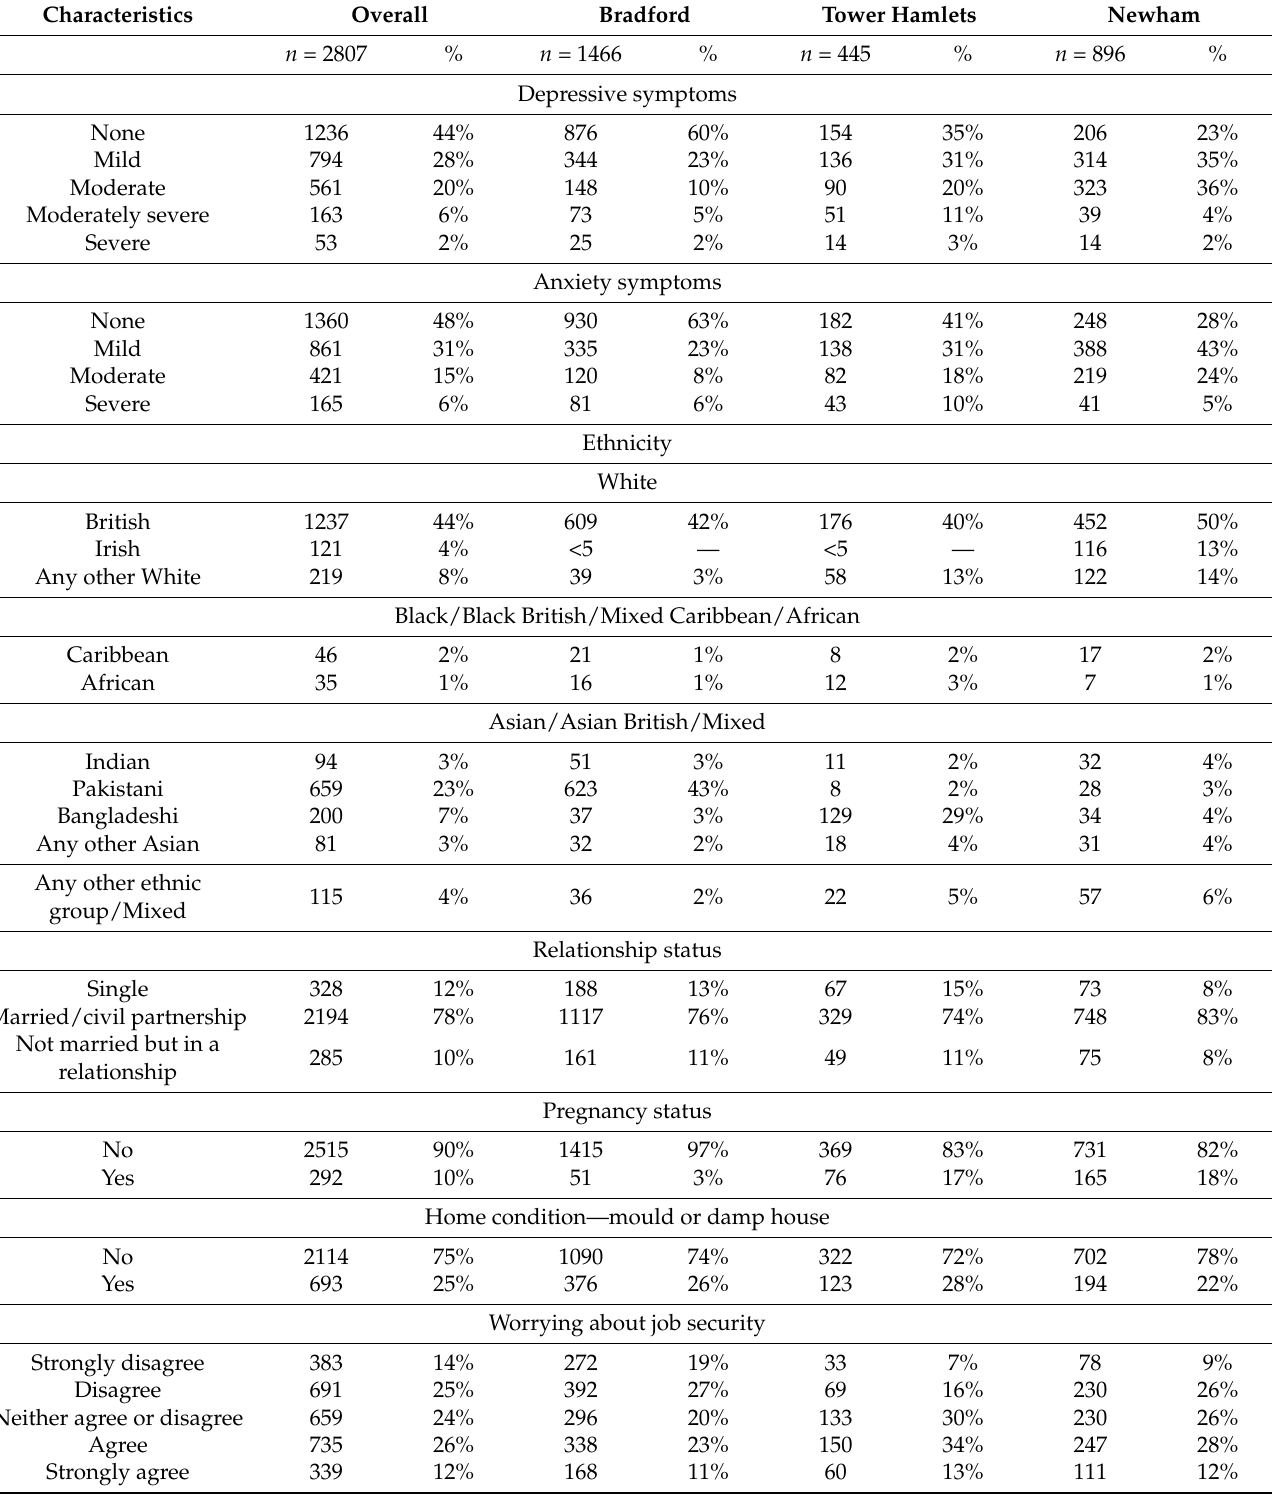
Table 1. Sample characteristics overall and by study